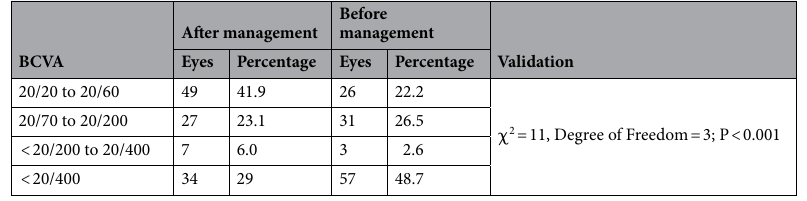
Table 6. Visual status before and after the management of Saudi children with fireworks-related ocular injuries. BCVA best-corrected visual acuity.